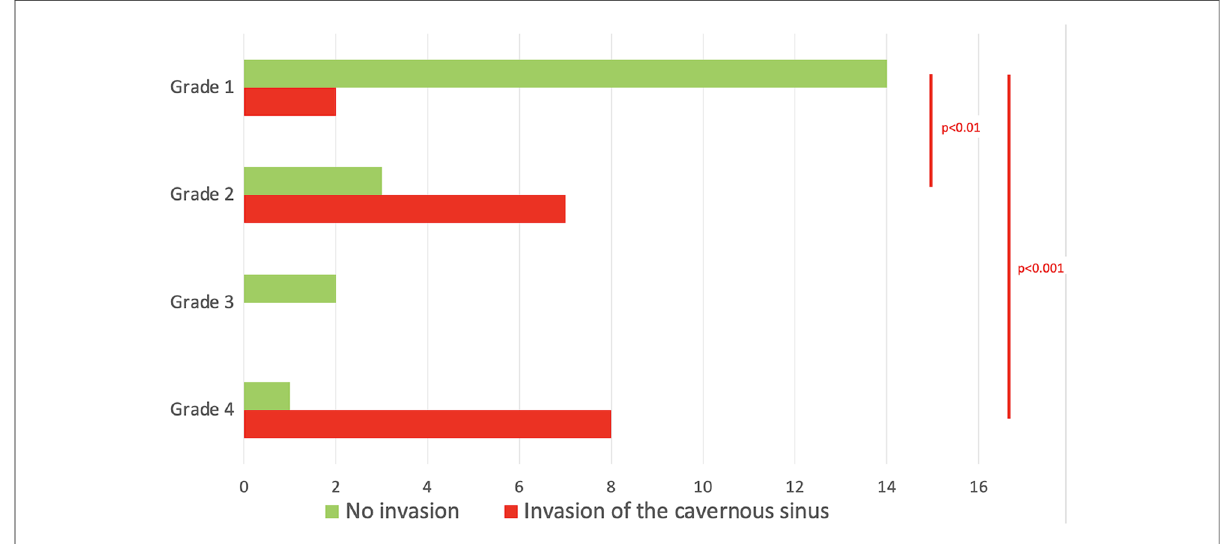
FIGURE 4 The invasion of the cavernous sinus is detailed for each